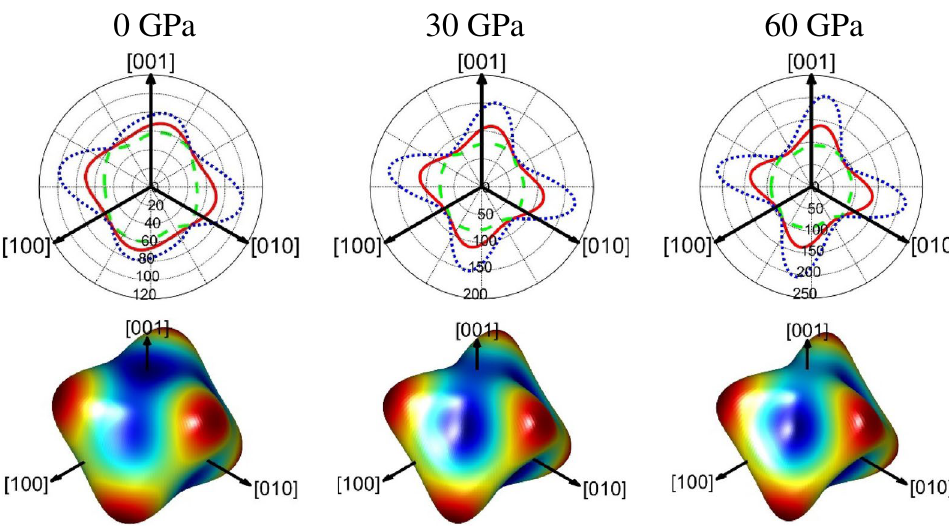
Figure 6. 3D spatial distribution and its projection of shear modulus for magnesite at various pressures.